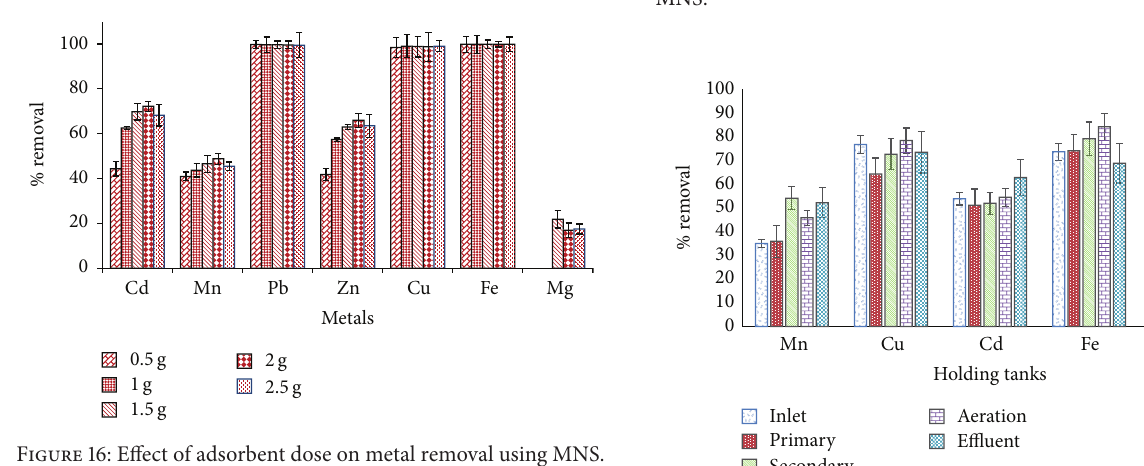
Figure 16: Effect of adsorbent dose on metal removal using MNS.